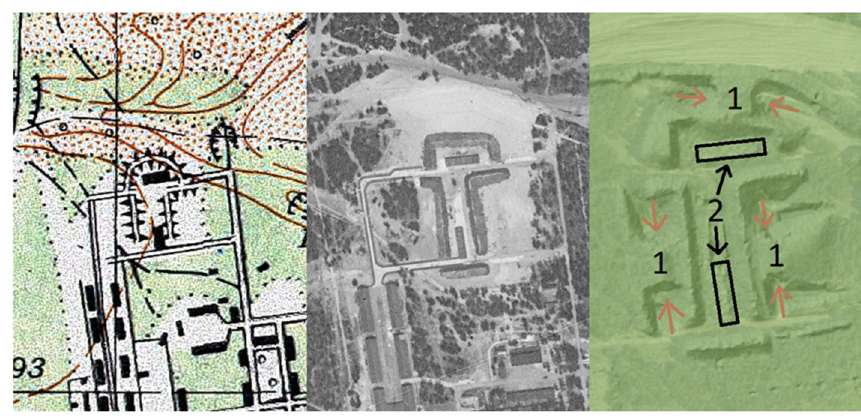
Fig. 7. Camuflaging of the “Granit” shelter in the Pstrąże (Stachów) garrison